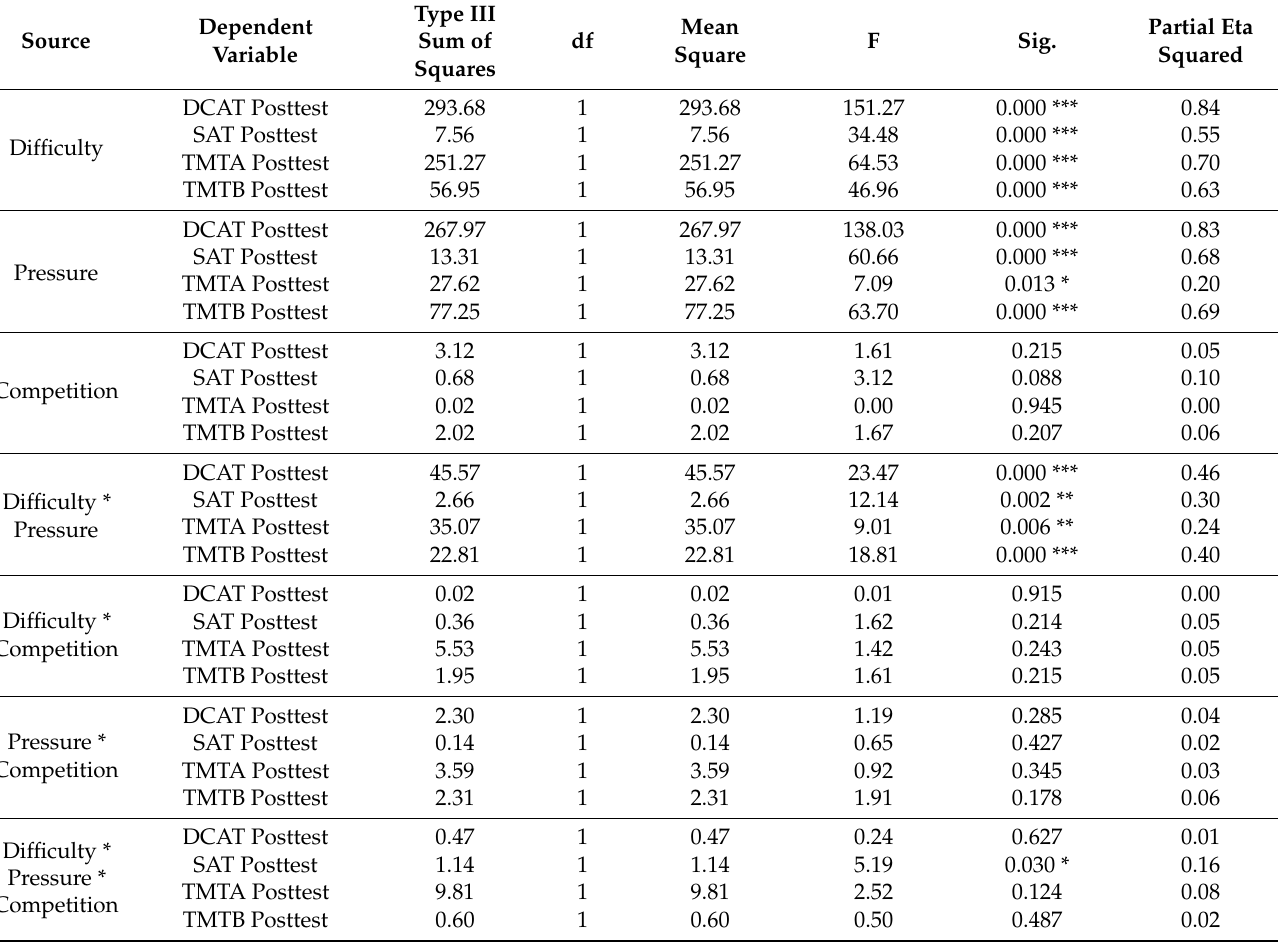
Table 25. Tests of between-subjects effects